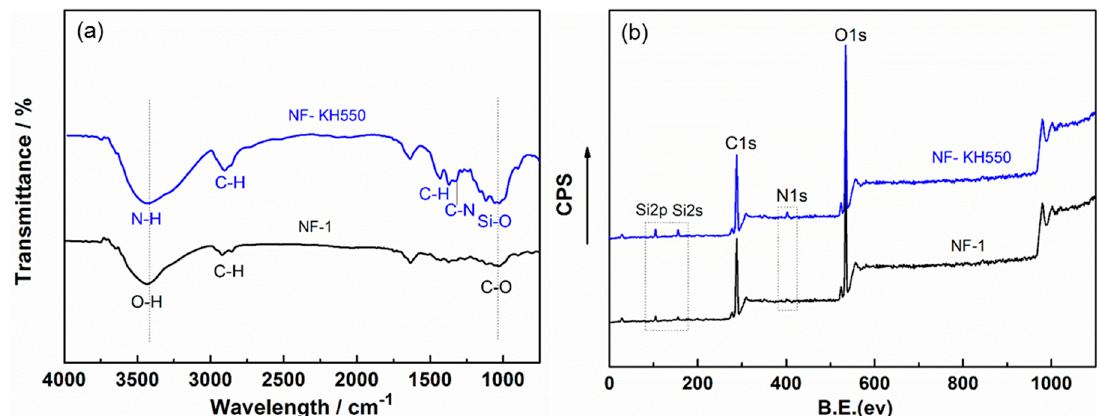
Figure 5. SEM imaging of different modified ramie fabrics.